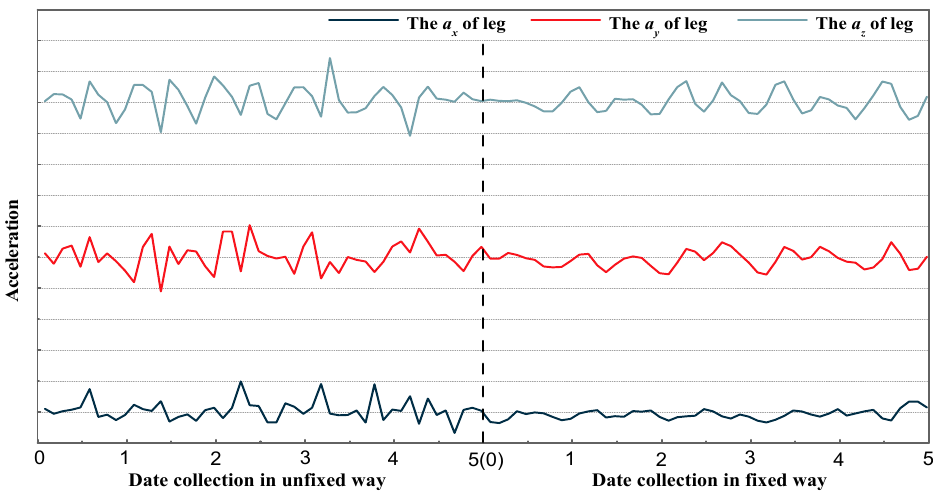
Figure 4. Sample acceleration data of walking based on smartphones based on two ways.